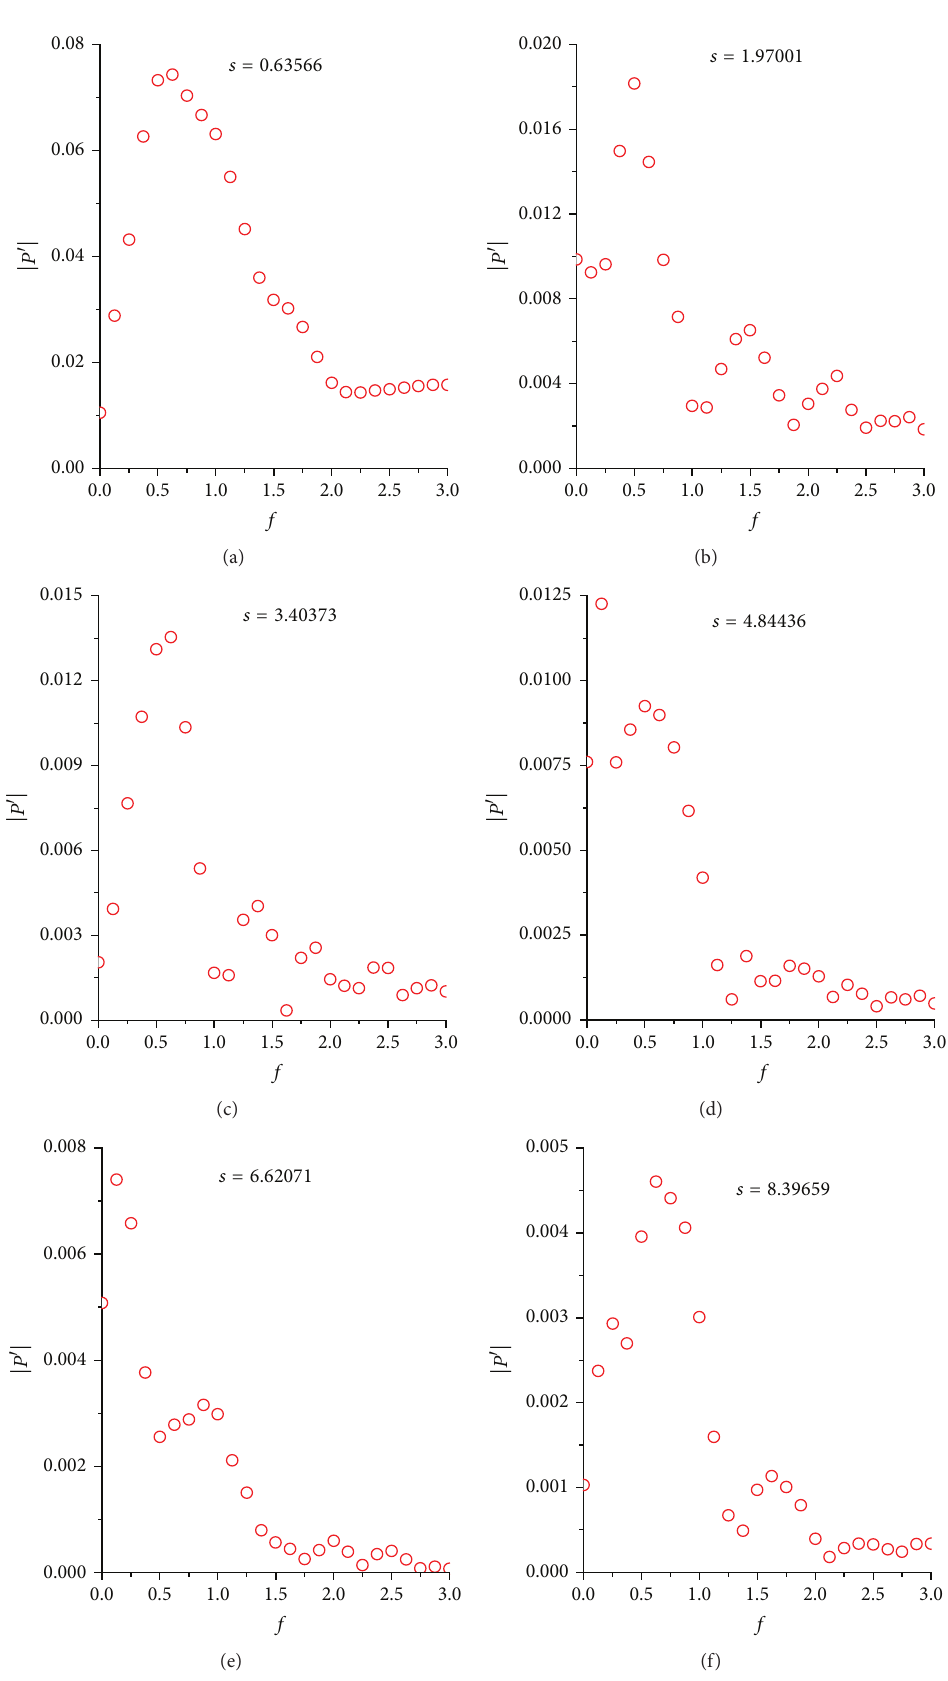
Figure 9: Frequency spectrum analysis of pressure disturbance at different locations in the ablation